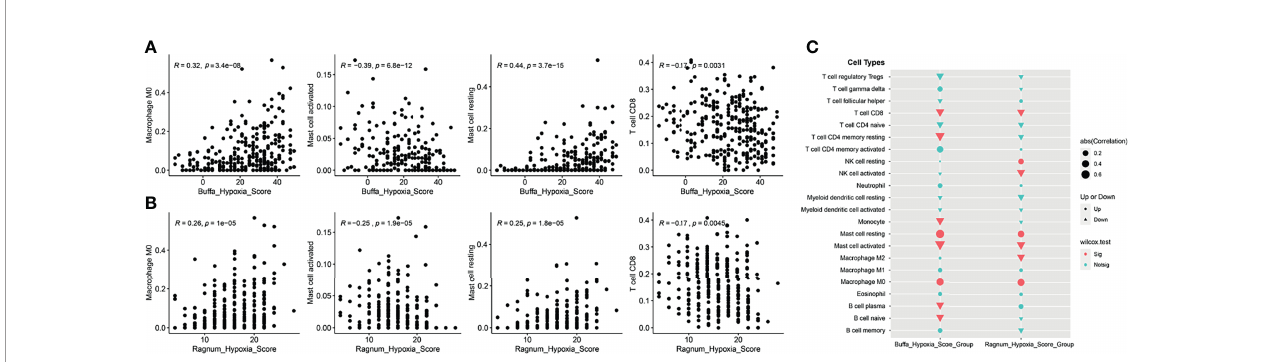
FIGURE 6 | The analysis of tumor microenvironment (TME). The correlation analyses between the buffa (A) or ragnum (B) hypoxia score and the in fi ltrated immune cells level. (C) Comparison of in fi ltrating immune cells between high- and low- hypoxia score groups. Up represents “ positive correlation ” , Down represents “ negative correlation ” . Sig represents “ signi fi cant ” , Notsig represents “ not signi fi cant